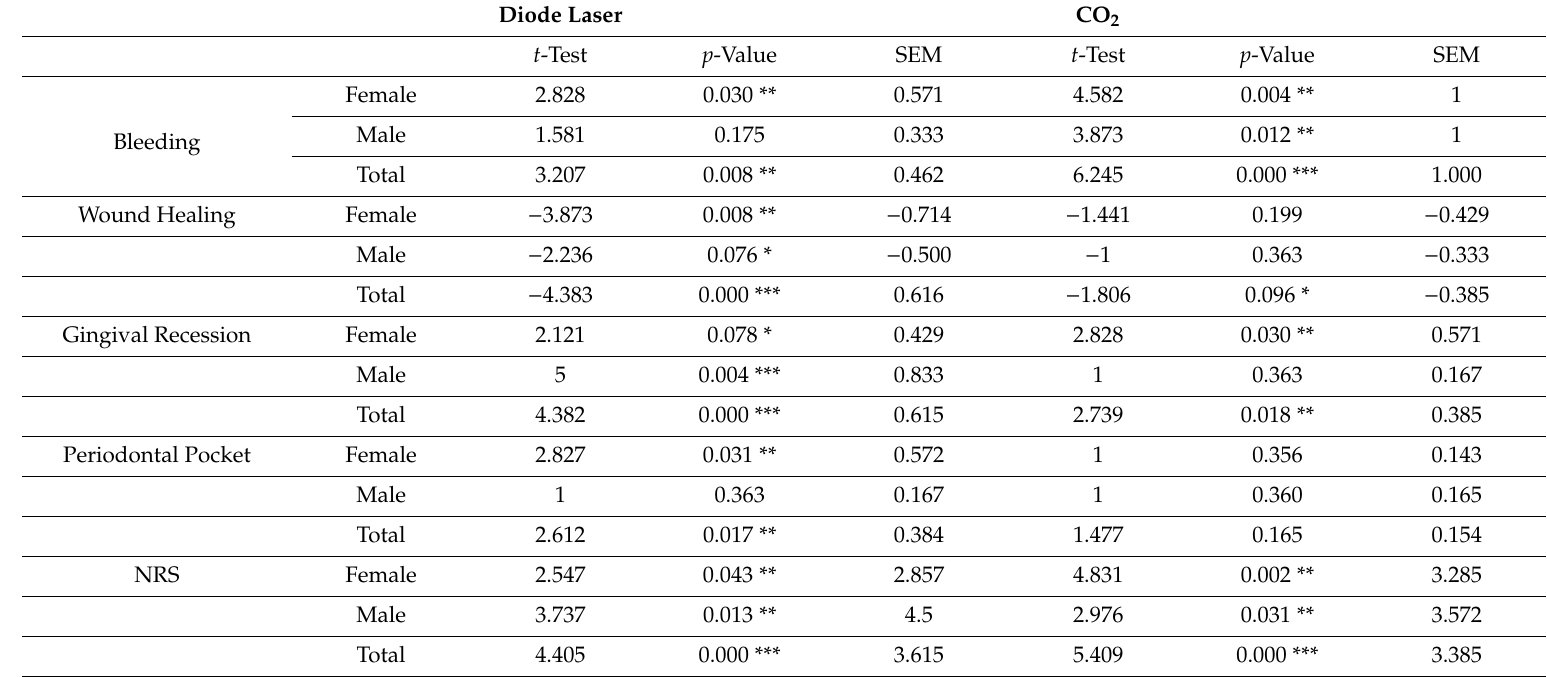
Table 4. Paired t -test results of the parameters (between T1 and